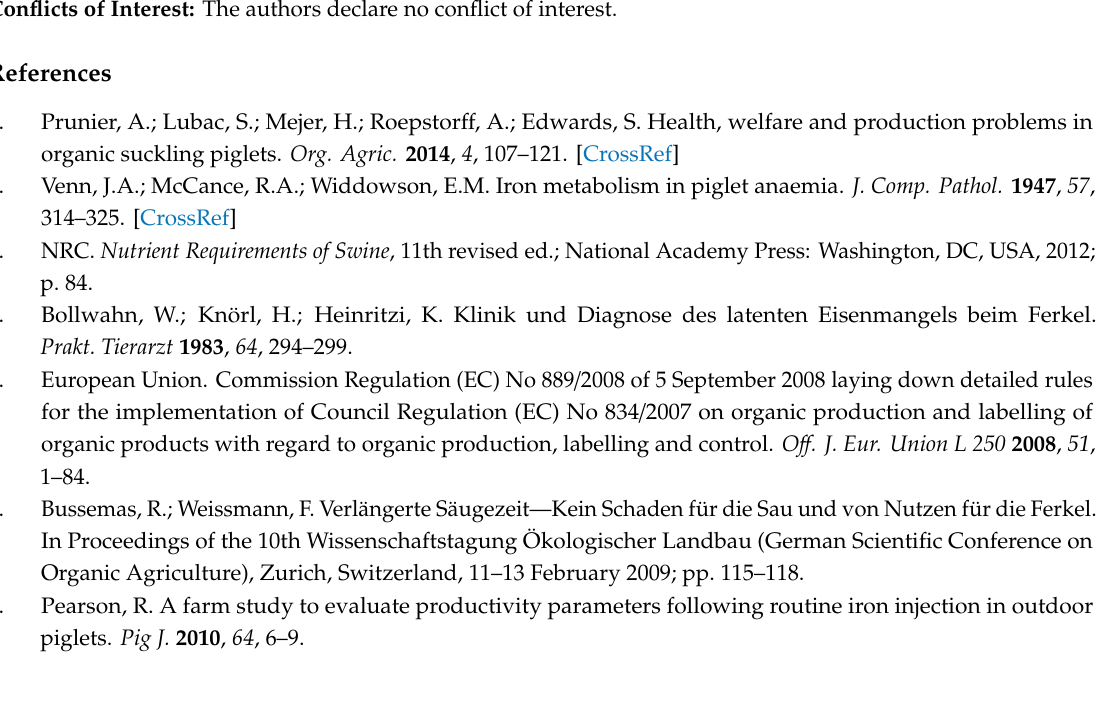
Table S1: Piglet growth and iron status when supplementing iron in di ff erent